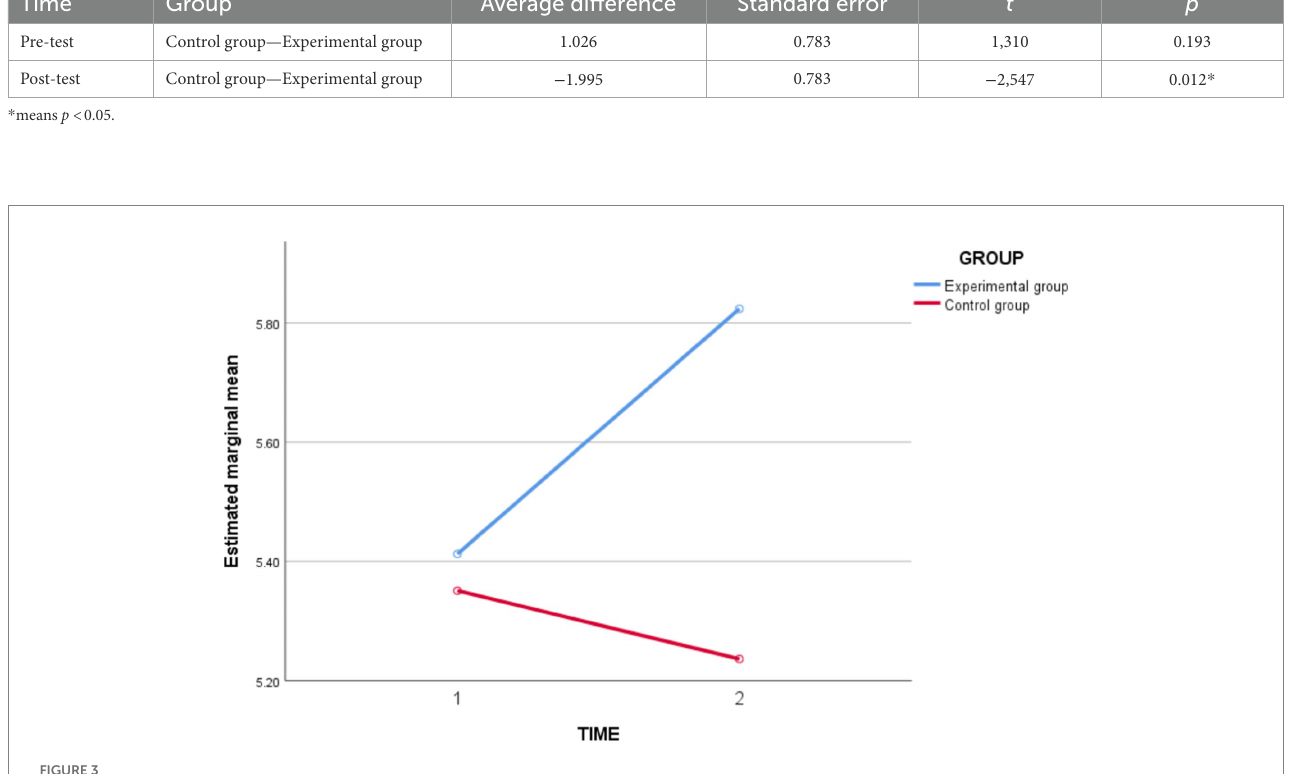
TABLE 3 Simple effects analysis of basketball skill level group between experimental group and control group before and after the intervention. Time Group Average difference Standard error t p